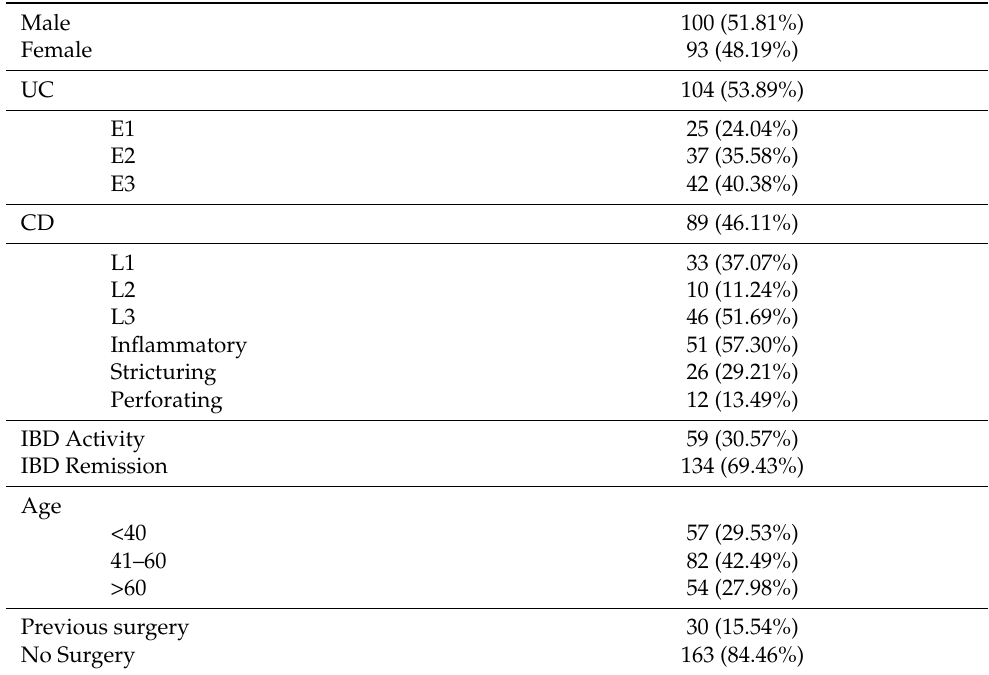
Table 1. Patient